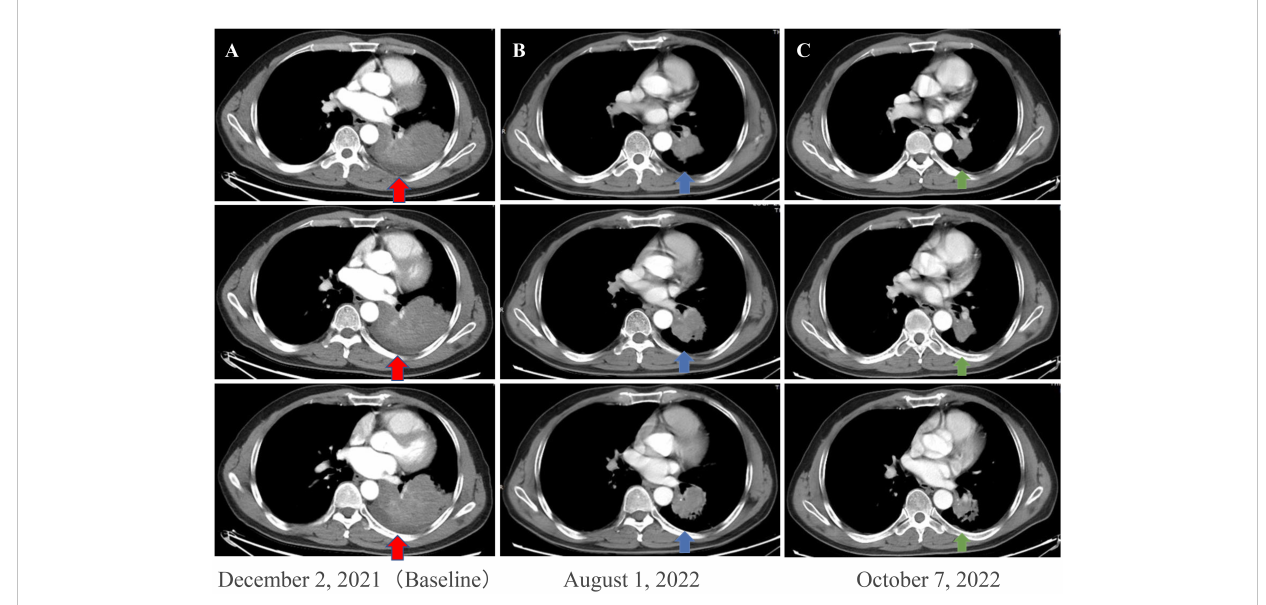
FIGURE 1 Enhanced chest CT scans of the patient during neoadjuvant therapy. (A) Baseline imaging demonstrating a 93 mm × 70 mm abnormal lung mass (red arrows) in the lower lobe of the left lung. (B) After 210 days of osimertinib therapy, the chest CT scan shows mass shrinkage (blue arrows) to 48 × 44 mm, achieving a partial response (PR). (C) After two cycles (42 days) of osimertinib and chemotherapy, the chest CT scan shows mass shrinkage (green arrows) to 40 mm × 37 mm, achieving a sustained partial response (sPR). CT, computed